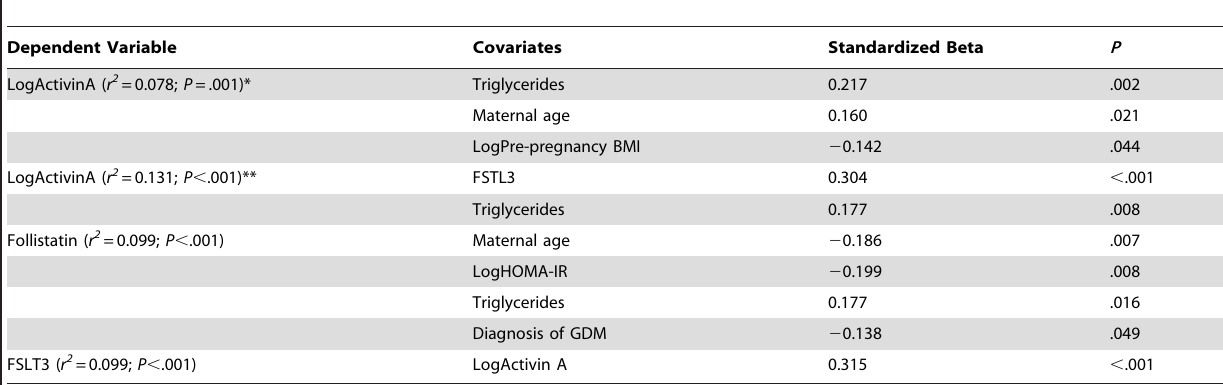
Table 2. Stepwise multiple linear regression models of activin A, follistatin and FSTL3.